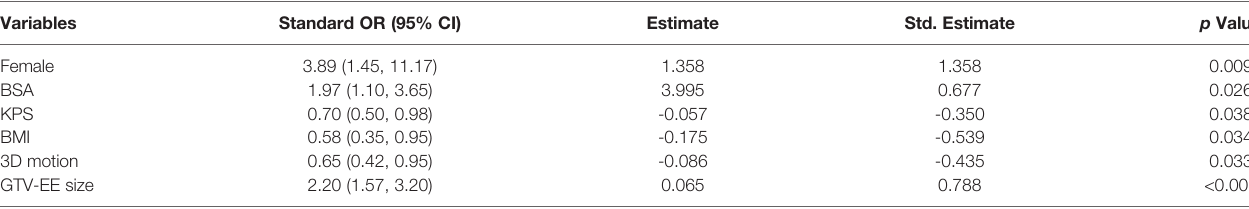
TABLE 2 | Odds ratios and 95% Con fi dence intervals of DSC (IGTV-MIP, IGTV-10).